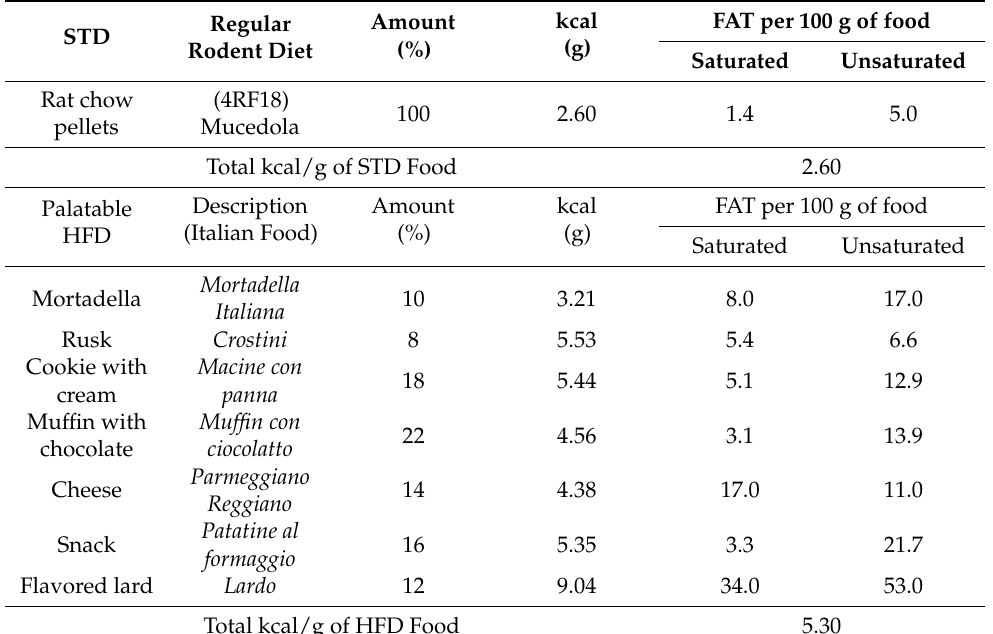
Table 1. Standard diet (STD) description and detail of the palatable hypercaloric cafeteria diet (HFD) products administered to obesity-induced